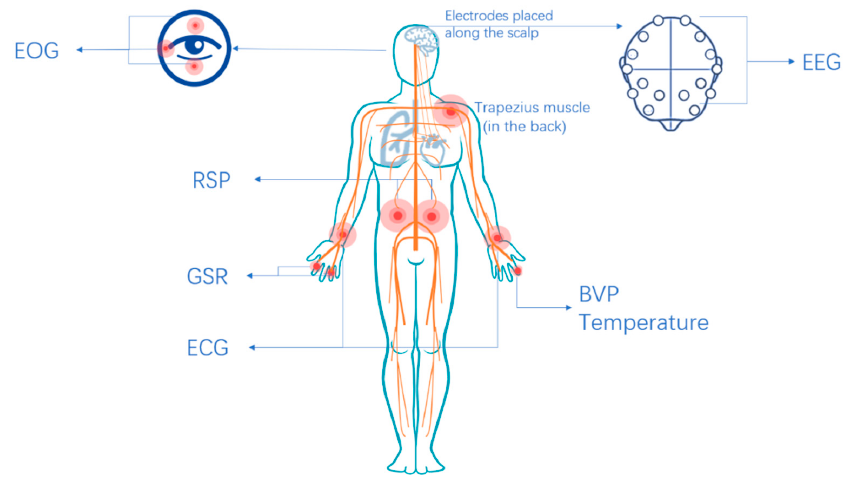
Figure 5. Position of the bio-sensors.